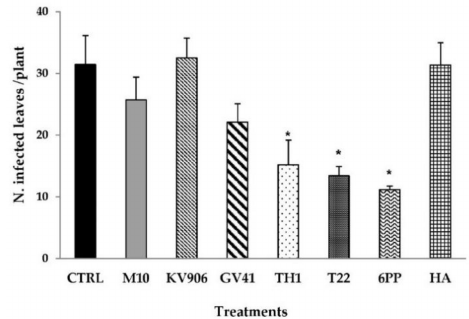
Figure 1. Number of olive leaves infected by Fusicladium oleagineum on plants treated with Trichoderma strains (M10, KV906, GV41, TH1, and T22) or secondary metabolites (6PP and HA). Plants treated with water (CTRL) were used as controls. Data are expressed as the mean value ± standard error. An asterisk (*) indicates values that are significantly di ff erent from the control (* p < 0.05; Student’s t